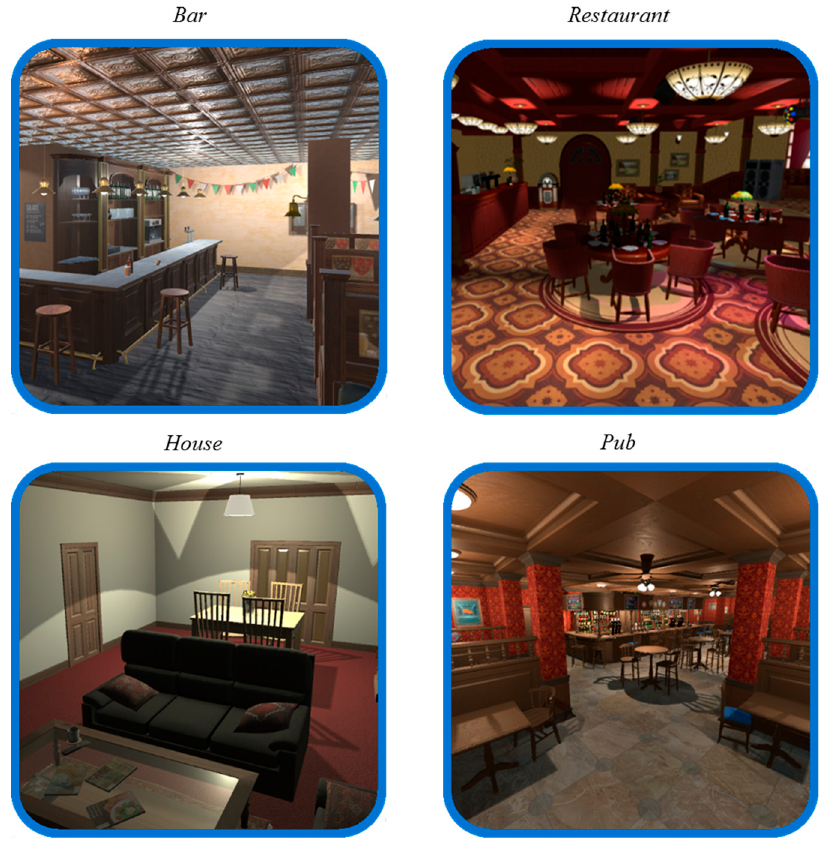
Figure 1. Pictures of the VR environments.